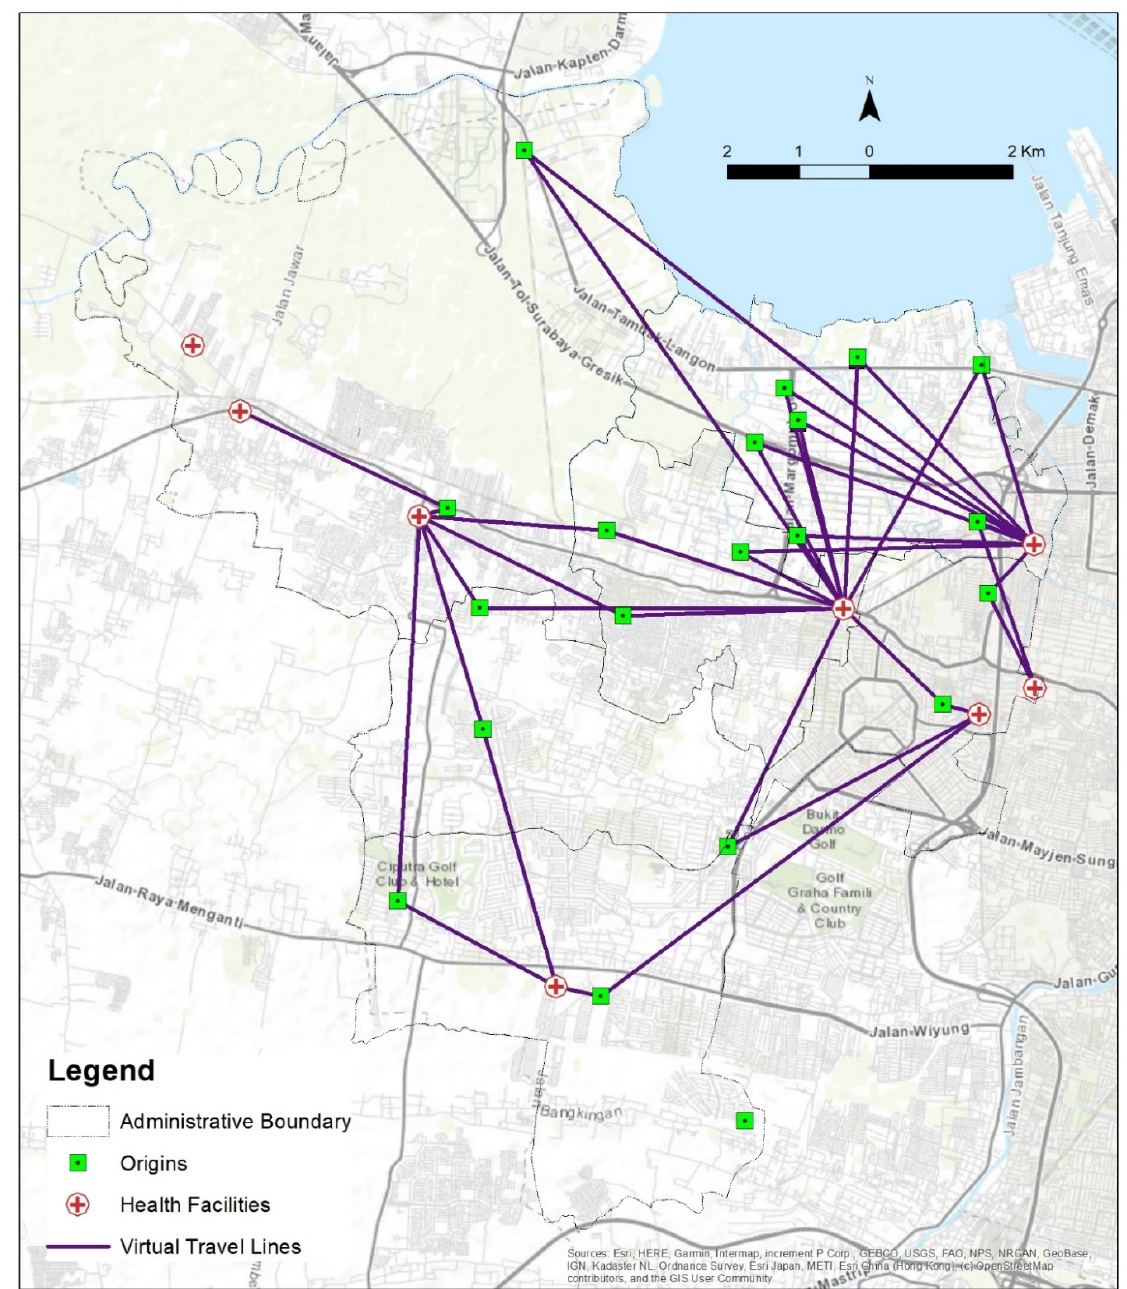
Figure 11. Route analysis before flood.